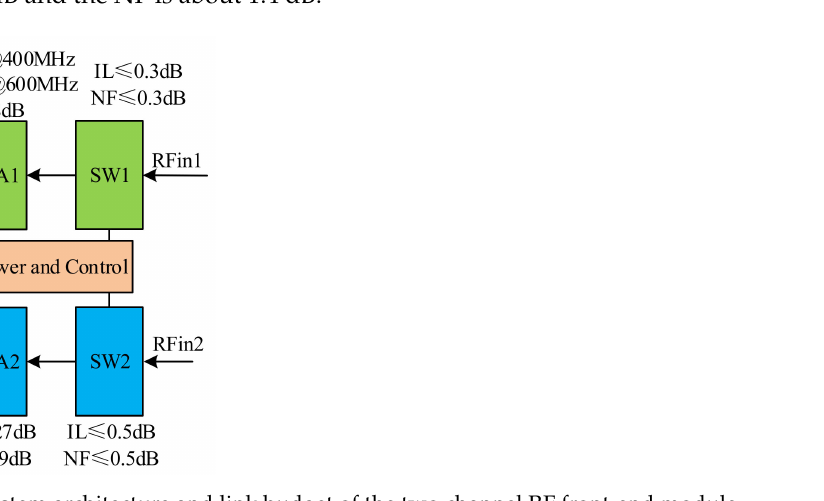
Figure 11. System architecture and link budget of the two channel RF front-end